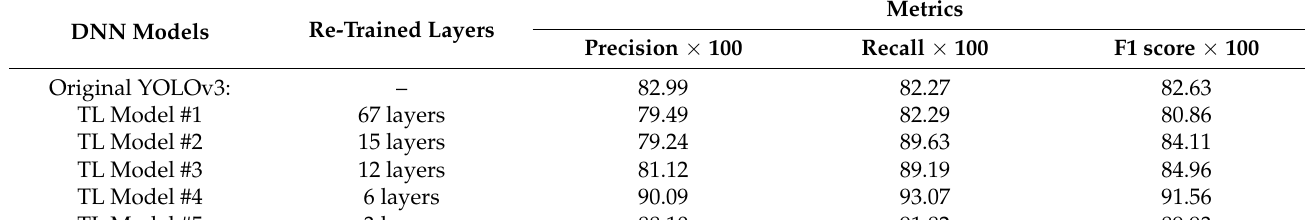
Table 1. Evaluation results of the DNN models for vehicle detection.